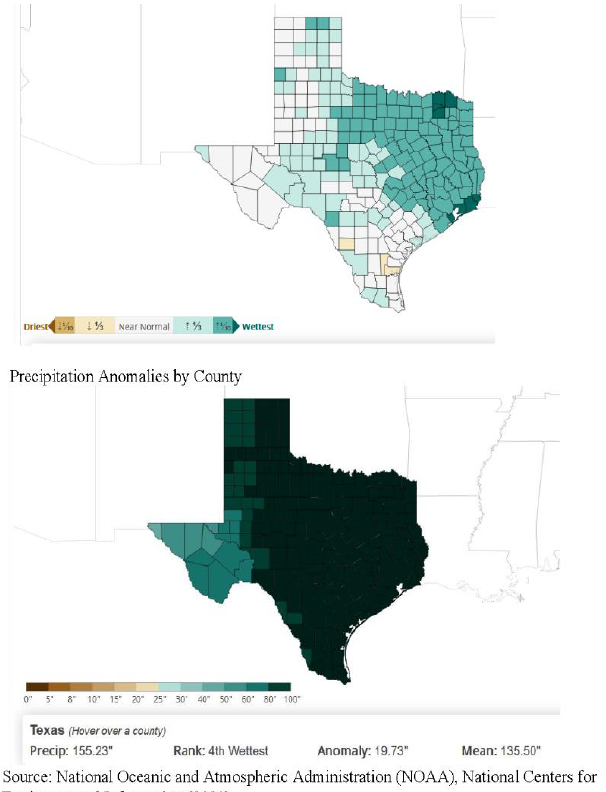
Figure 8. Annual precipitation and precipitation anomalies by Texas county, 2015–2020, month of July.